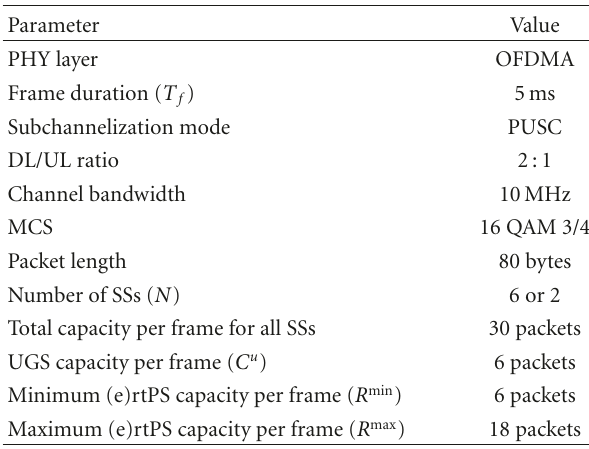
Table 1: Basic evaluation parameters.